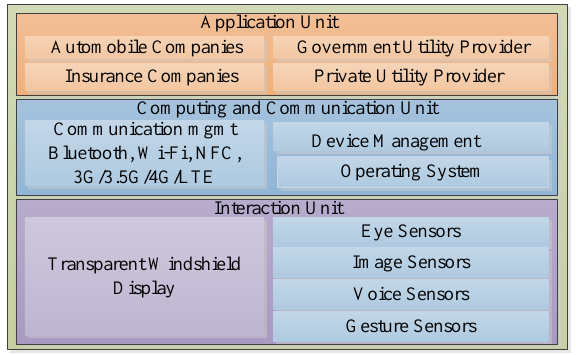
Figure 3. System architecture of a Smart Car demonstration platform.